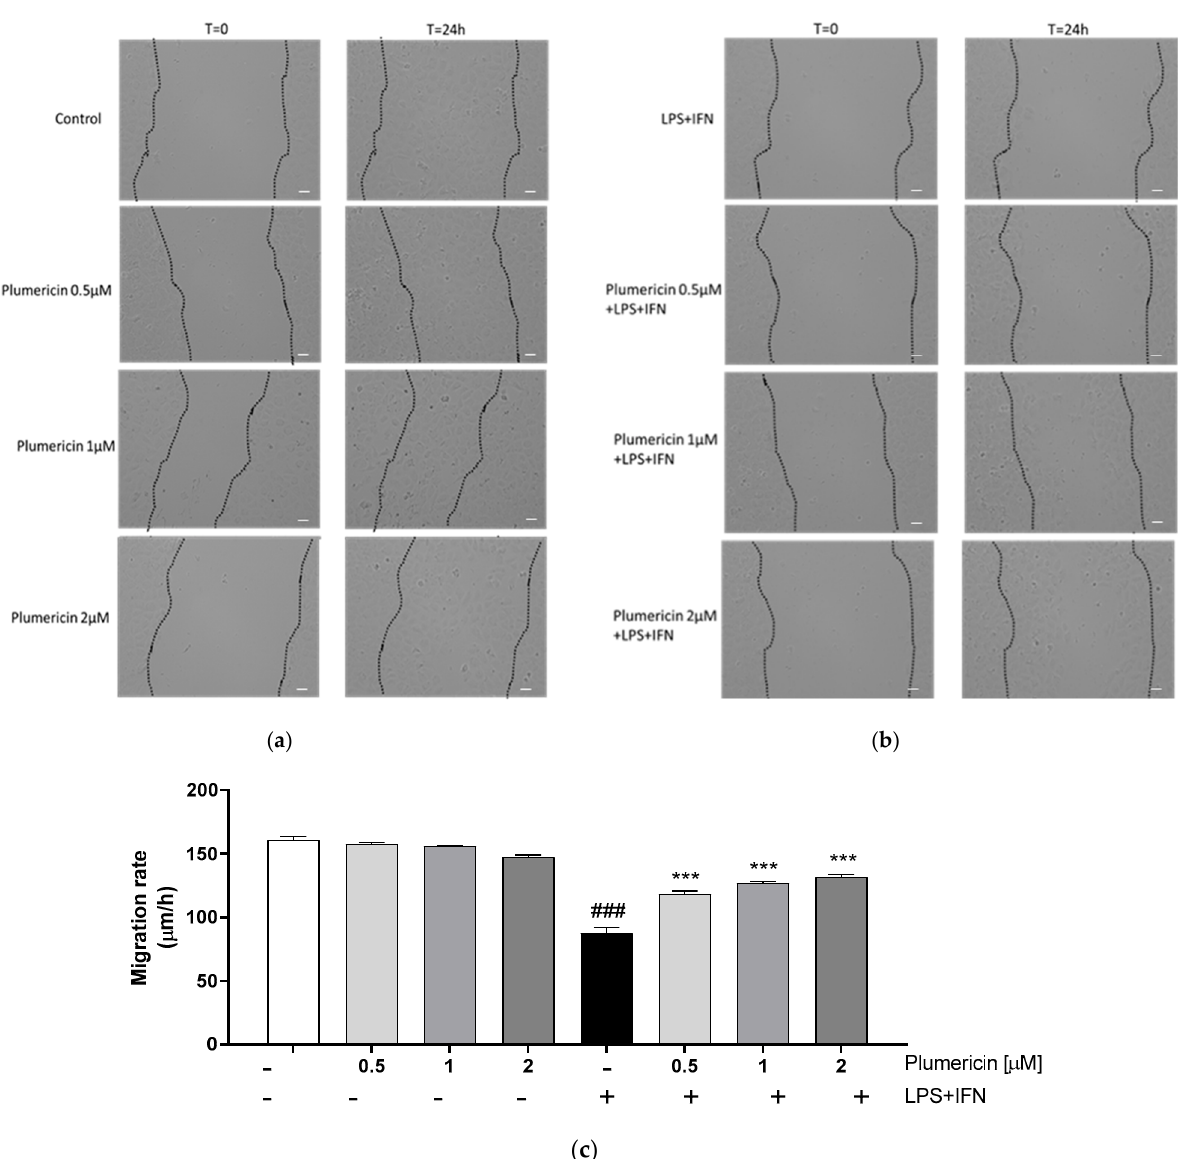
Figure 3. Effect of plumericin alone and in presence of LPS + IFN on cellular migration, evaluated by wound-healing assay. Pictures representing the wound repair, induced by mechanical scratch in IEC-6, from plumericin treatment alone ( a ) and in combination with LPS + IFN ( b ). Bar = 150 µ m. ( c ) representing the quantitative analysis expressed as IEC-6 migration rate after 24 h. Values are expressed as migration rate ( µ m/h). ### indicates p < 0.001 vs. untreated cells; *** indicates p < 0.001 vs. LPS +